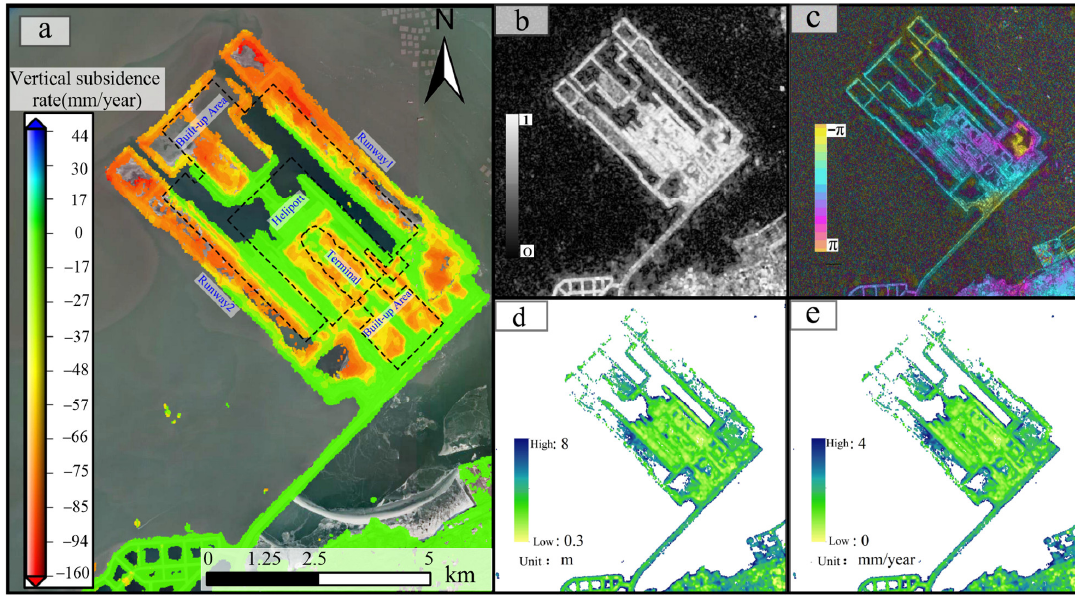
Figure 7. ( a ) Average annual subsidence rate distribution derived from descending track; ( b ) Average coherence coefficient diagram; ( c ) Differential interferogram (20200817–20200910); ( d ) Distribution of elevation residuals; ( e ) The error map of mean velocity results.